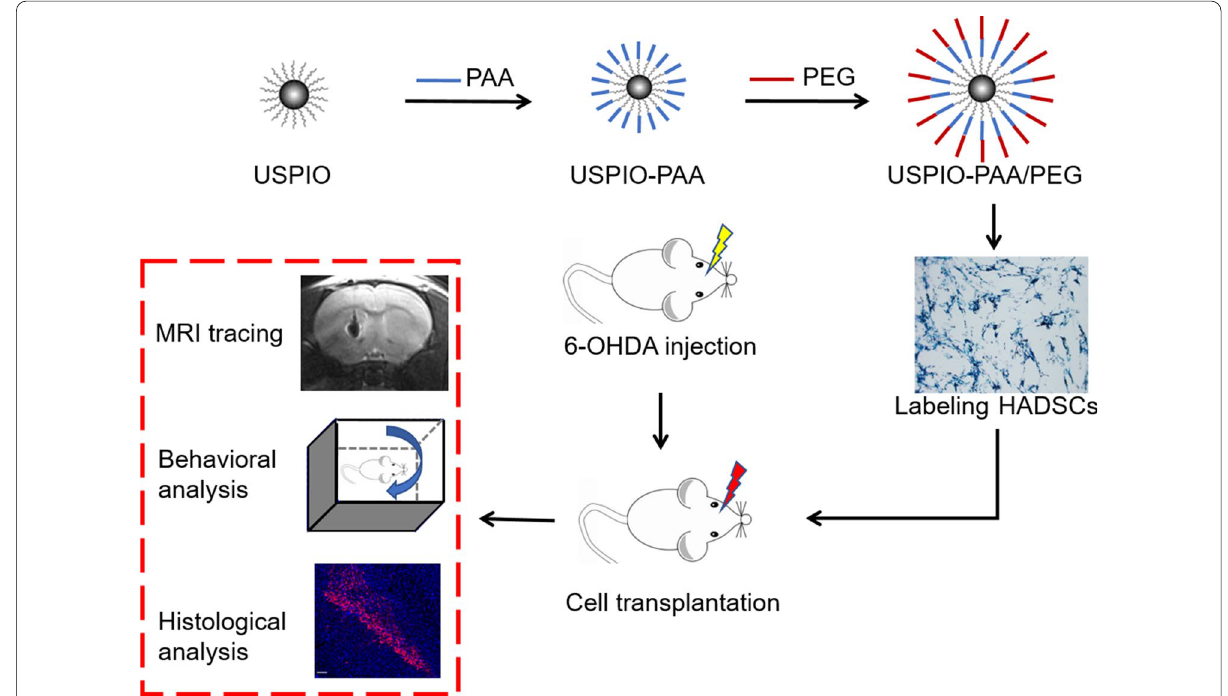
Fig. 1 Schematic illustration of the experimental